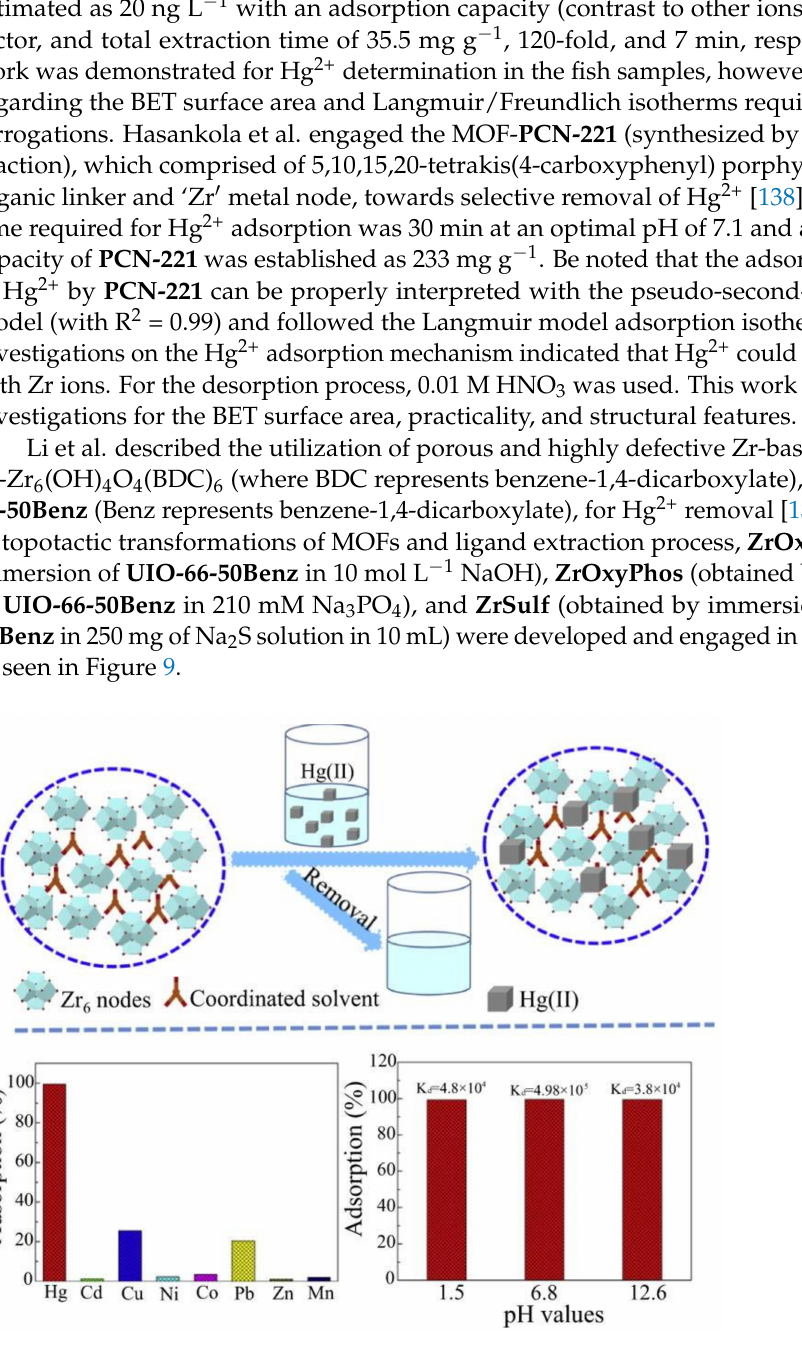
Figure 9. Schematic of the utilization of highly defective Zr-based porous MOFs- ZrOx , ZrOxyPhos , and ZrSulf towards Hg 2+ removal and excellent Hg 2+ removal performance by ZrSulf compared to other metal ions and at different pH ranges; coordinated solvents NaOH, Na 3 PO 4 , and Na 2 S were used to afford ZrOx , ZrOxyPhos , and ZrSulf , respectively. (Reproduced with the permission from Ref